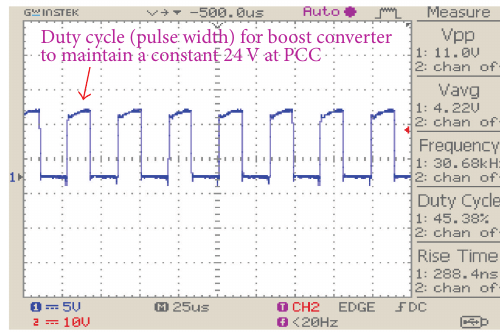
Figure 28: Control pulses (duty cycle) of boost converter generated by the voltage